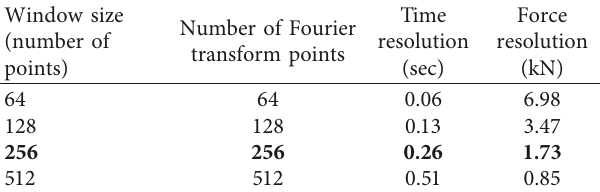
Table 2: Time and force resolution for different window sizes.